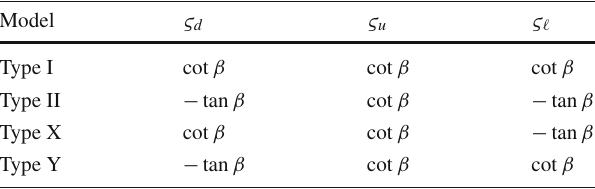
Table 1 The one-to-one correspondence between the different choices ofthealignmentparameters ς f andthefourconventional2HDMsbased on discrete Z 2 symmetries